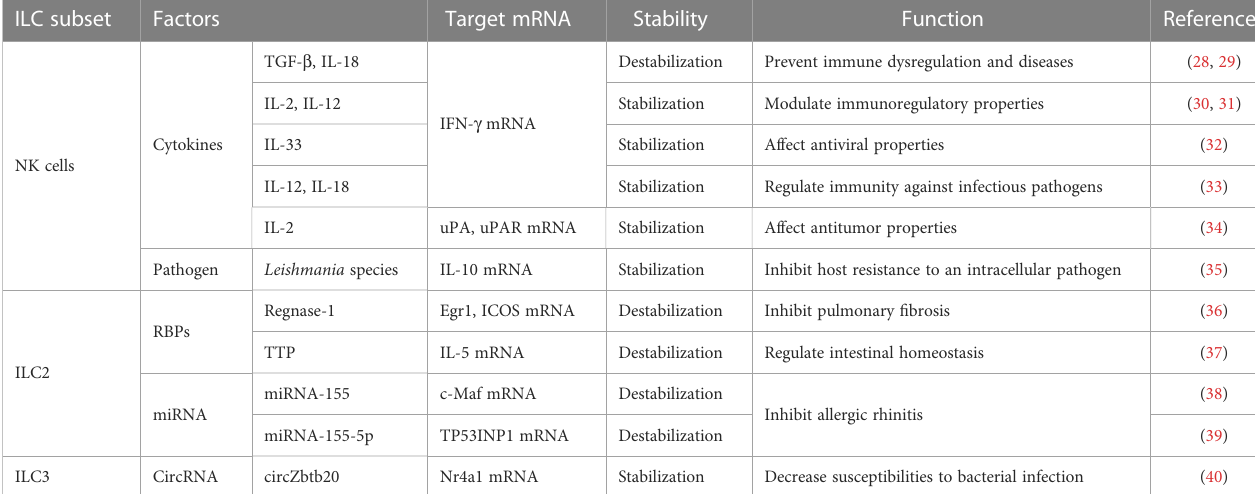
TABLE 1 Regulation of mRNA stability in ILCs is involved in various